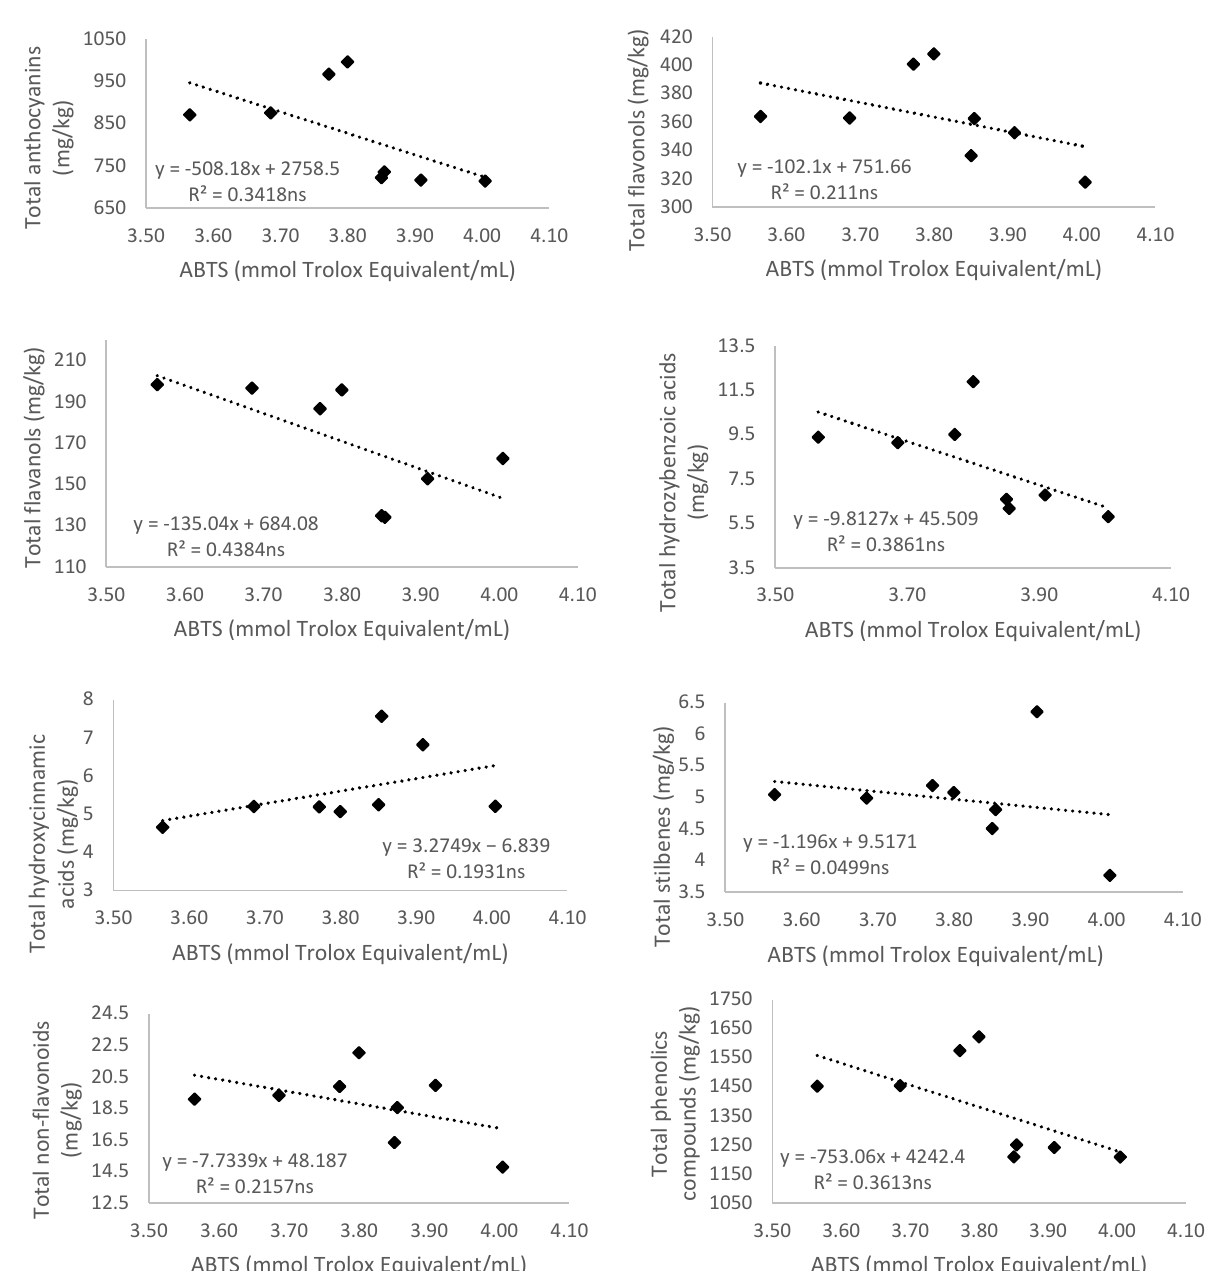
Figure 3. Relationship of the 2,2 ′ -Azino-bis(3-ethylbenzthiazoline-6-sulfonic acid) (ABTS) (mmol Trolox/mL) and total anthocyanins, flavonols, flavanols, hydroxybenzoic and hydroxycinnamic acids, stilbenes, non-flavonoids, and content of total phenolic compounds (mg/kg) of Monastrell grapes. Values of the coefficient of determination (R 2 ) are presented. Lines of linear regression are shown: there are no significant differences ( p > 0.05, ns).